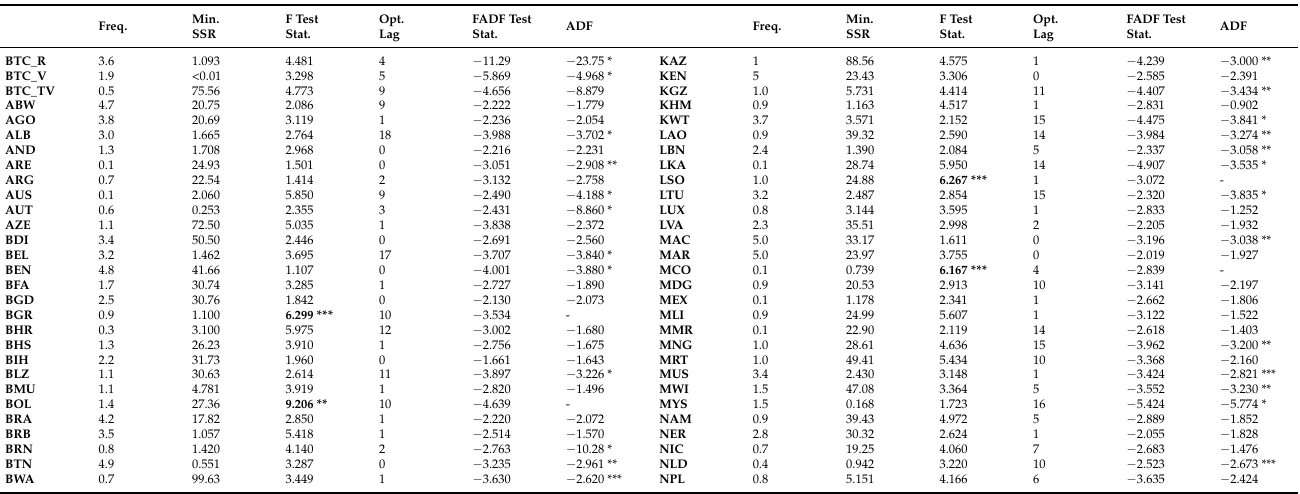
Table 3. Results of FADF and ADF unit root tests a